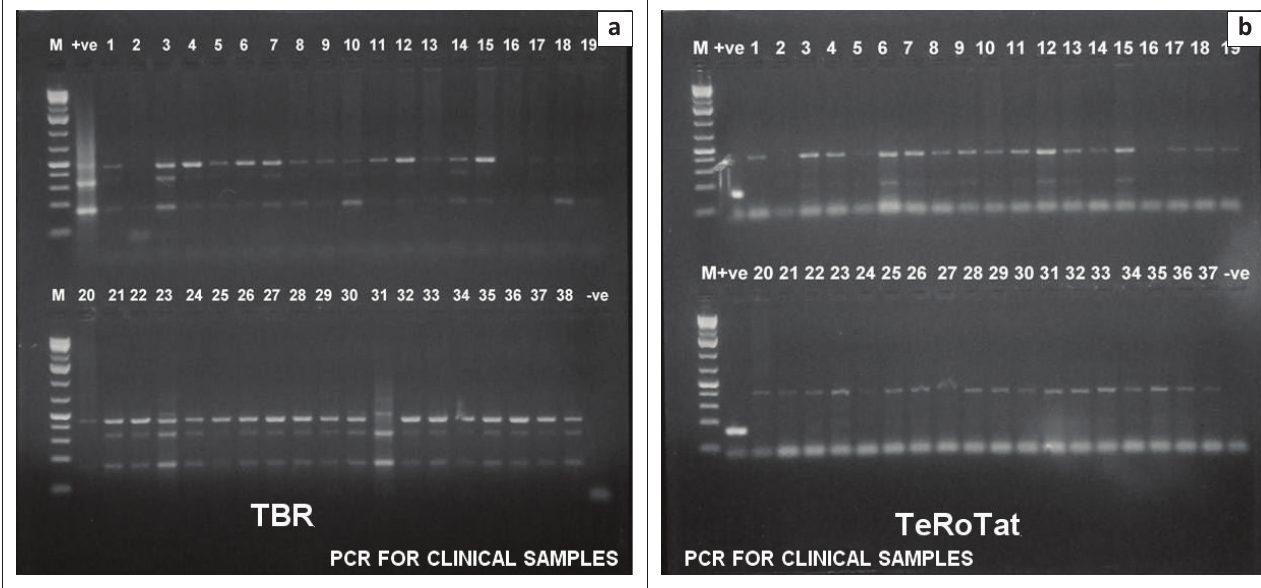
FIG URE 8: Polymerase chain reaction results of field blood samples with Trypanosoma brucei 1/2 (164 base pairs) and T. evansi Rode Trypanozoon antigen type (RoTat) 1.2. (151 base pairs) primers sets: M: 100 base pairs molecular weight Deoxyribonucleic acid marker, +ve: positive control Trypanosoma evansi Deoxyribonucleic acid and -ve: negative control. (a) TBR and (b)